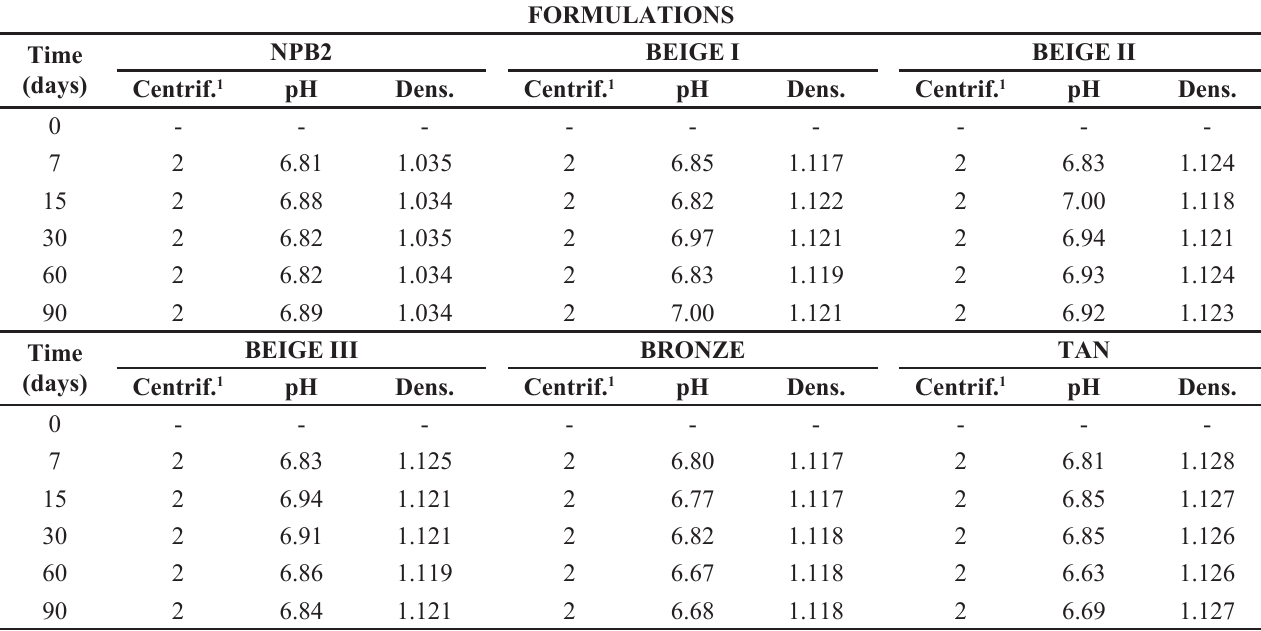
TABLE XI - Results of centrifugation tests (Centrif.), pH and density (Dens.) of the NPB2 base and corrective makeup stored at 37.0 ± 2.0 ºC for up to 90 days